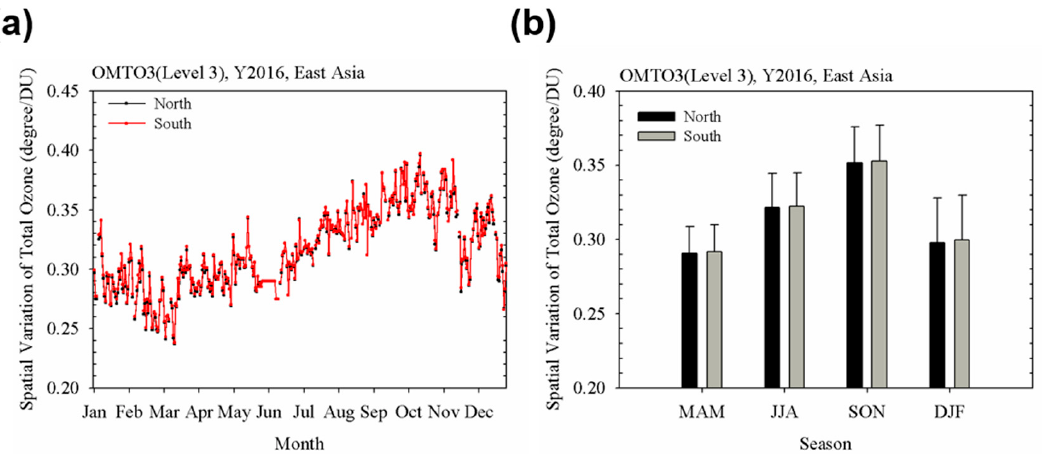
Figure 6. ( a ) Daily change and ( b ) seasonal change for latitudinal variability of the TCO by using Level 3 gridded datasets from the Ozone Monitoring Instrument (OMI) in Year 2016.